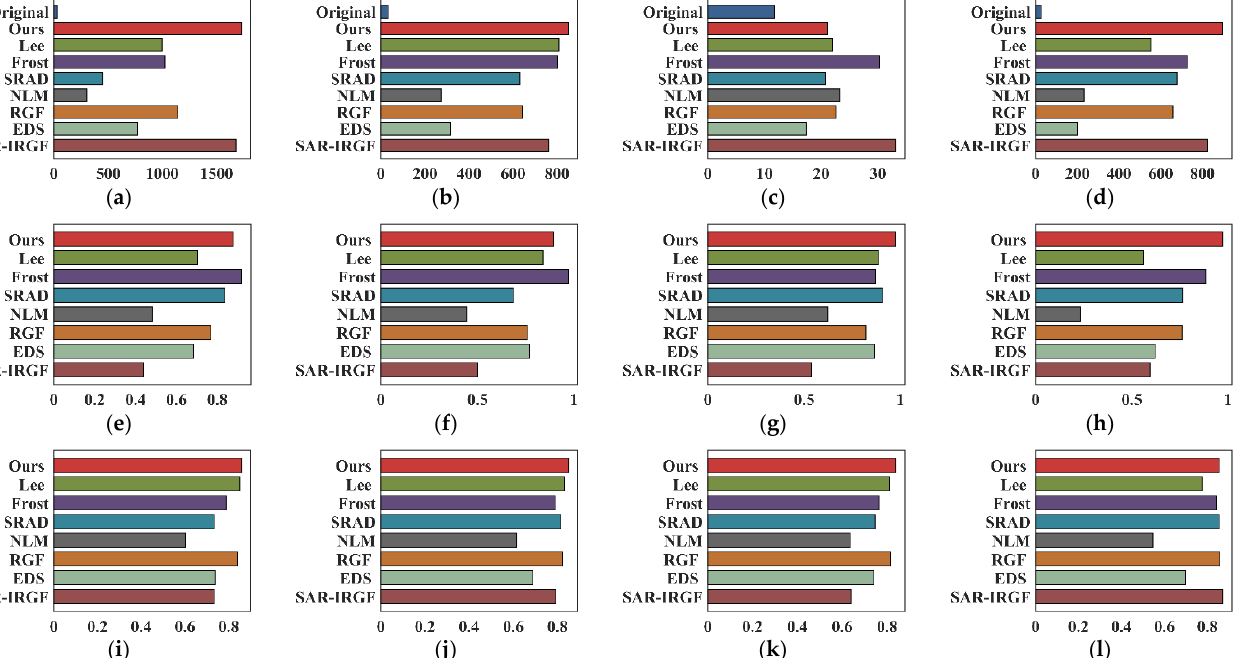
Figure 15. Experimental results of four optical images: ( a1 - 8 ) are the denoising results for the Plant of our method, Lee filter, traditional Frost filter, SRAD, NLM, RGF, EDS, and SAR-IRGF, respec- tively. ( b1 - 8 ) are the denoising results for the Clamps of our method, Lee filter, traditional Frost filter, SRAD, NLM, RGF, EDS, and SAR-IRGF, respectively. ( c1 - 8 ) are the denoising results for the Keyboard of our method, Lee filter, traditional Frost filter, SRAD, NLM, RGF, EDS, and SAR-IRGF, respectively. ( d1 - 8 ) are the denoising results for the Apple of our method, Lee filter, traditional Frost filter, SRAD, NLM, RGF, EDS, and SAR-IRGF, respectively